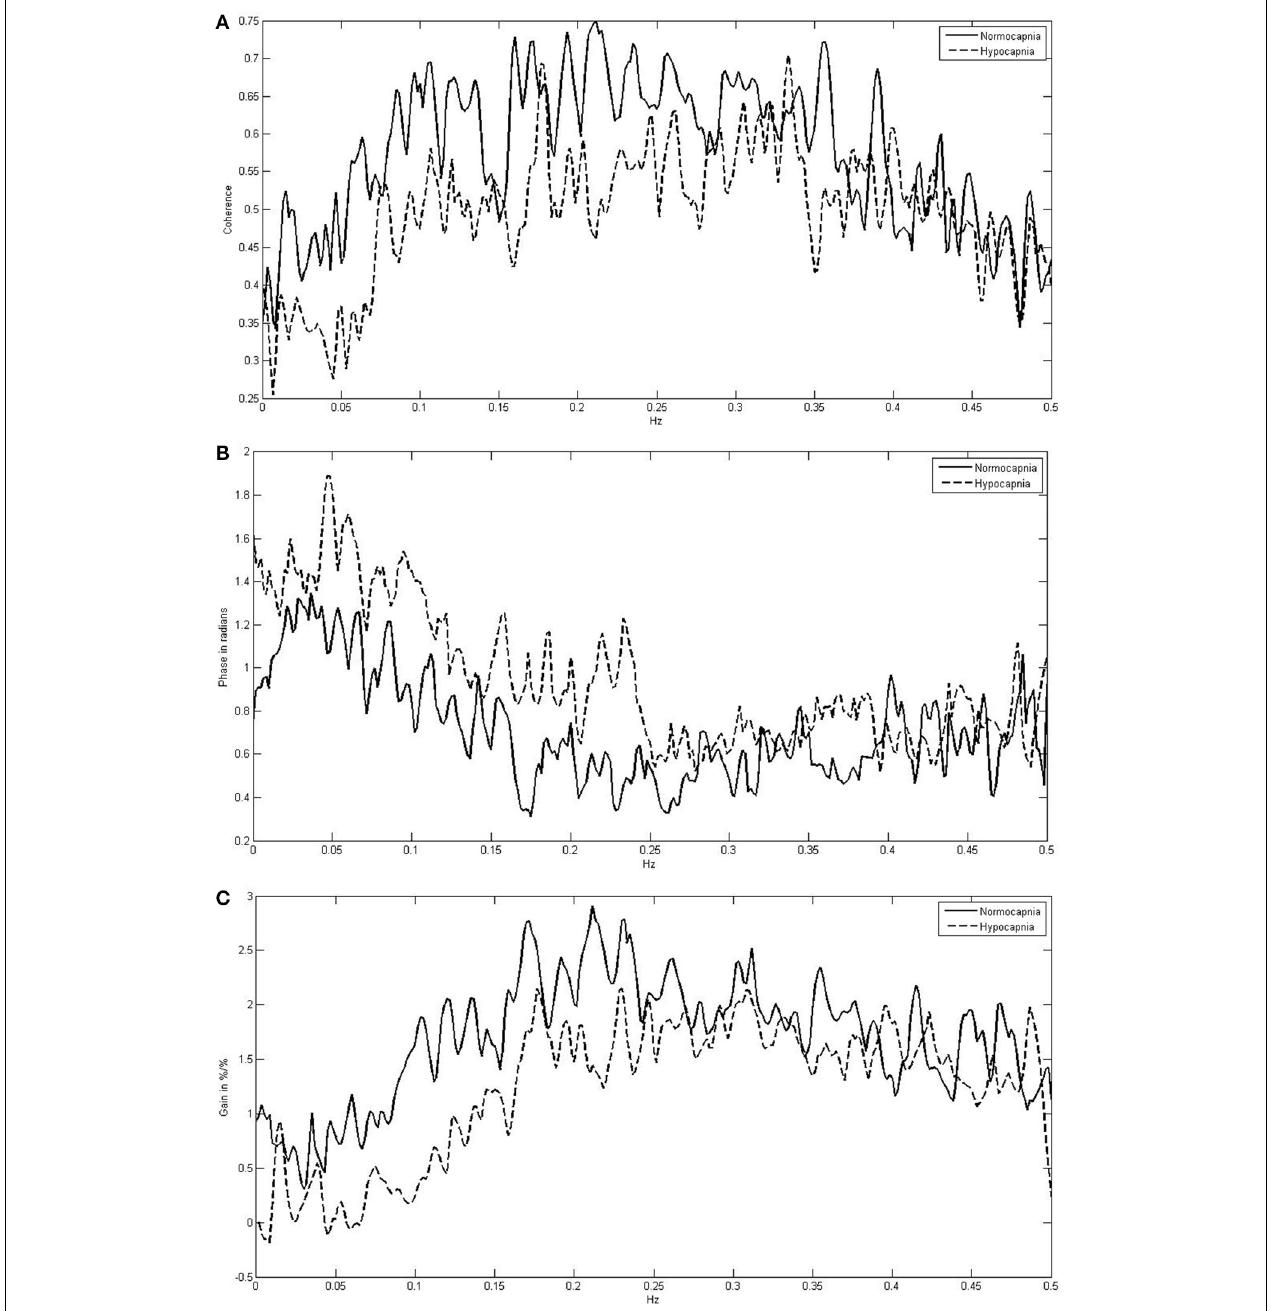
FIGURE 1 | Frequency-dependent mean coherence (A), phase (B), and gain (C) between blood pressure and cerebral blood flow velocity comparing normocapnia (normoventilation) with hypocapnia